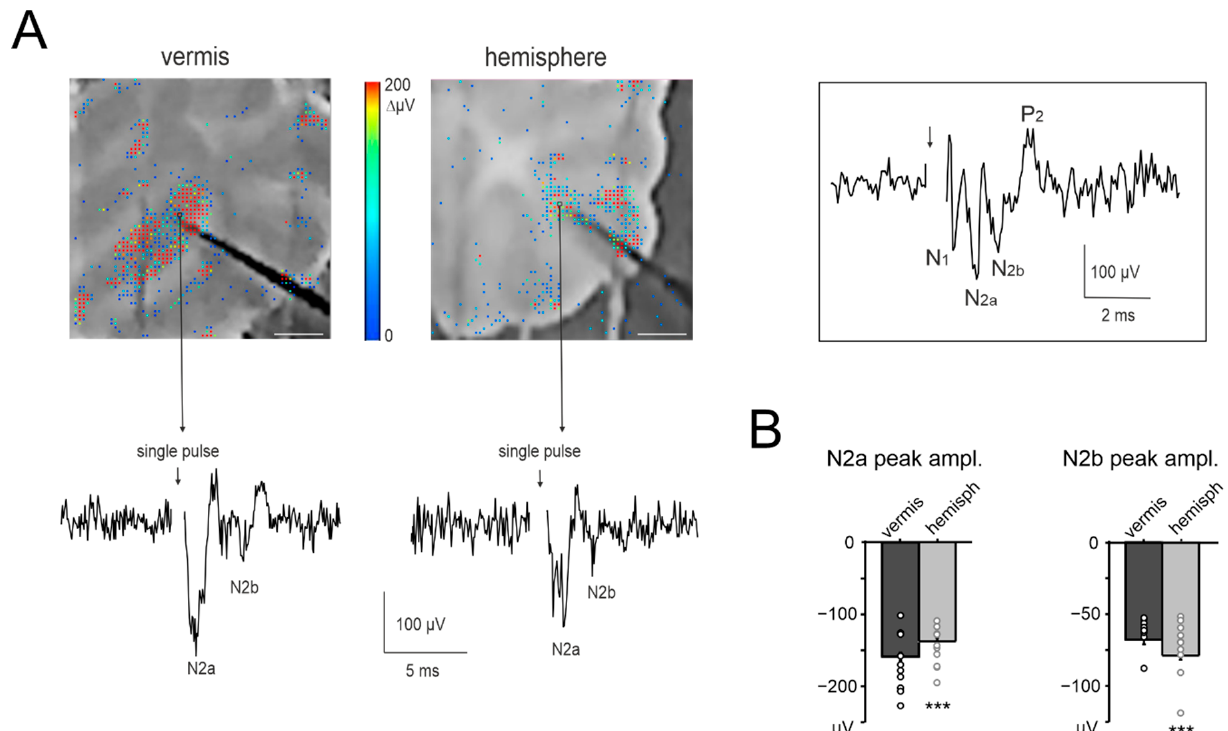
Figure 3. NA recordings in the cerebellar granular layer. ( A ) Example of a vermis and hemisphere cerebellar slice placed on the HD-MEA biochip (scale bar 0.5 mm). The activity following single- pulse stimulation of mossy fibers is superimposed in a color-scale (2 ms bin). A representative trace is shown from the HD-MEA biochip channel indicated by the arrow. The stimulus intensity and stimulating electrode is the same as used in Figure 1B. The inset shows the entire N 1 -N 2a -N 2b -P 2 complex that comprises the classic LFP in the granular layer (see Methods for details). ( B ) The histograms show the average peak amplitude of N 2a and N 2b , for both the vermis and hemisphere ( n = 10 slices for both) and the single data points. Statistical significance is indicated by asterisks (*** p <